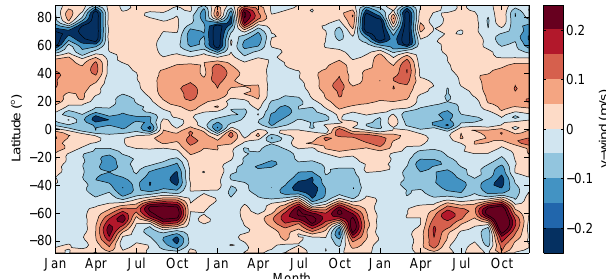
Figure B1. Meridional wind components (positive values from south to north) at 25km altitude in CTRL simulation with